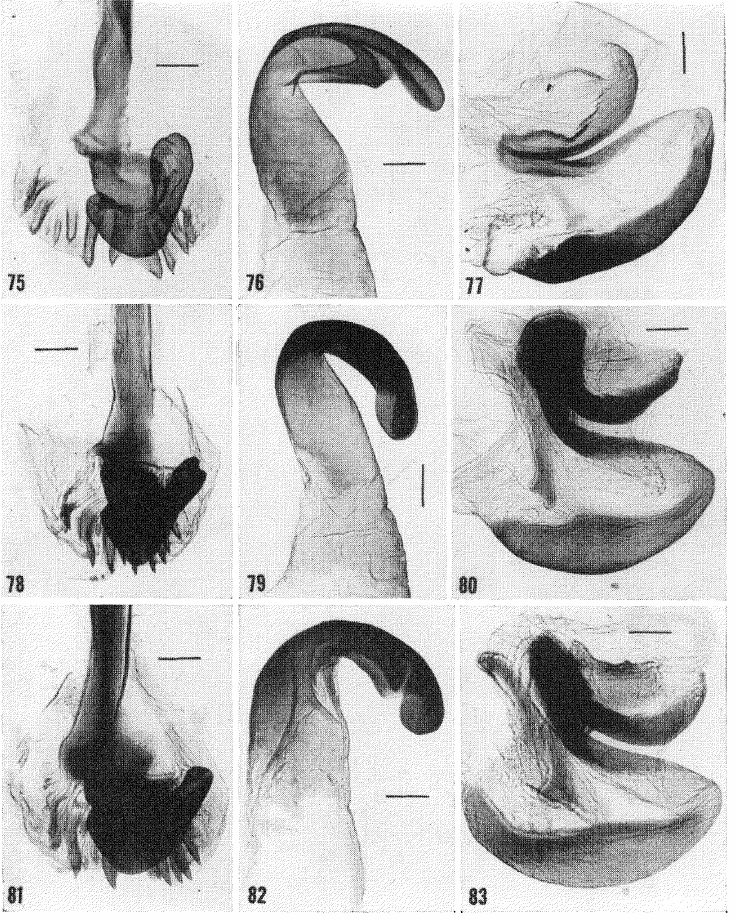
Figs. 75-83. 75-77. (N). Byrsotria fumi.qata (det. Roth). 78-80. (25 ANSP). Byrsotria cabrerai. (from specimen shown in Fig. 24). 81-83. (15 MCZ). B. cal, rerai. Coast below Pico Turquino, Cuba. (det. Gurney). (scale 0.3